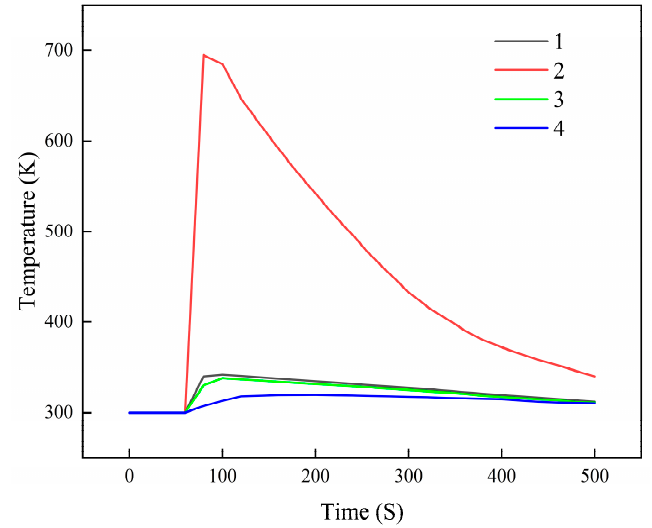
Figure 14. The maximum body temperature of each battery in model d under TR (when setting No. 2 battery TR).